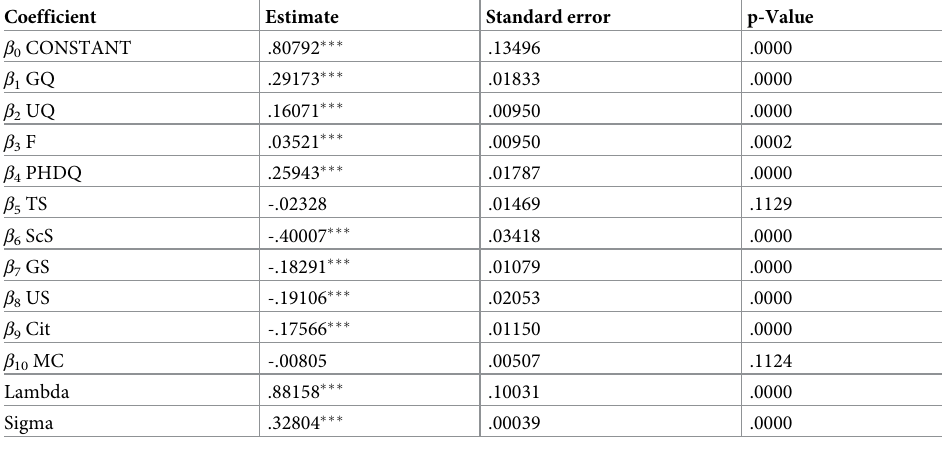
Table 6. Estimation results for the stochastic frontier Cobb-Douglas